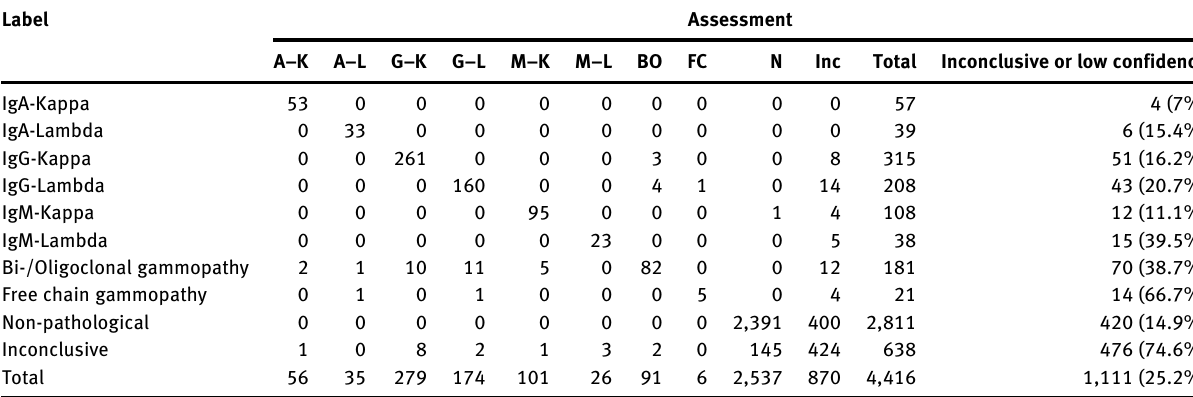
Table  : Confusion matrix of the automated assessment of the test dataset images compared to their labels. Label